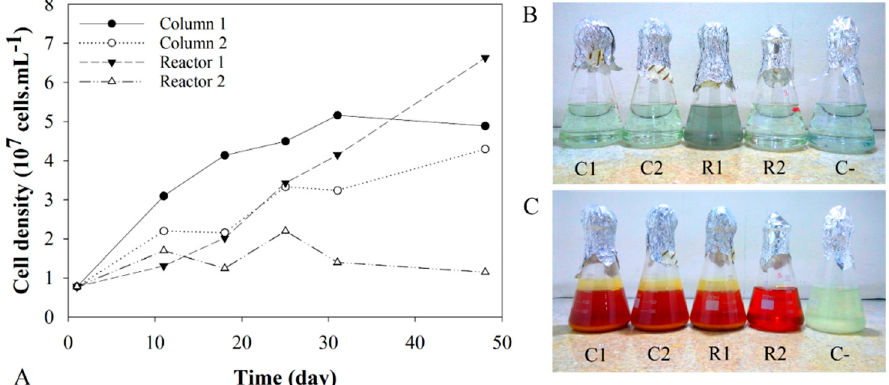
Figure 5. A. ferrooxidans population dynamics ( A ) along the columns and stirred reactors bioleaching experiments. Viability test of A. ferrooxidans cells collected from the columns/reactors leaching solution after the 50th day bioleaching showing the T & K 8 medium color before ( B ) and after iron oxidation ( C ). C1: Column 1. C2: Column 2. R1: Reactor 1. R2: Reactor 2. C-: Negative control. Planktonic bacterial population on columns leaching solution reached a final density around 4.9 × 10 7 cells·mL − 1 (column 2) and 4.3 × 10 7 cells·mL − 1 (column 2), after 47 days experiment (Figure 5A).